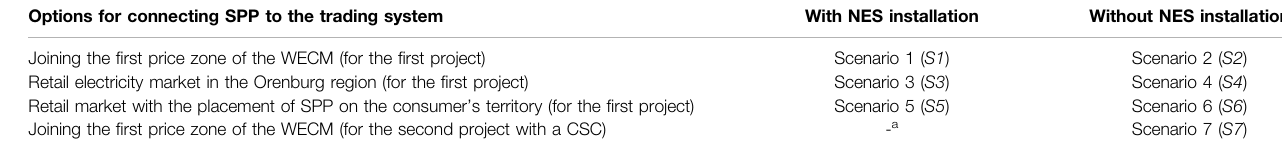
TABLE 3 | Scenarios for connecting SPP to the electricity and capacity trading